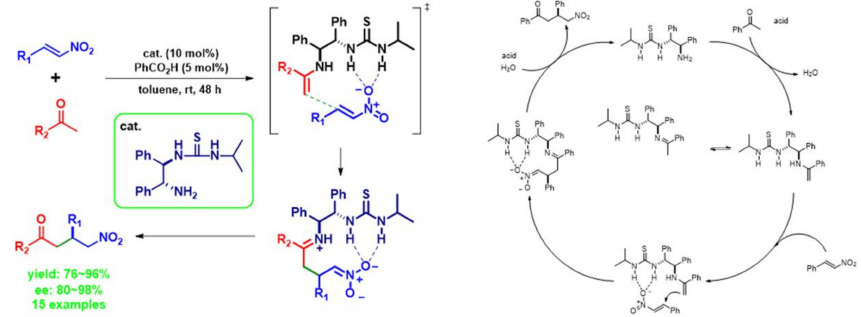
Scheme 2. Representative schematic of organocatalytic asymmetric Michael addition reaction.